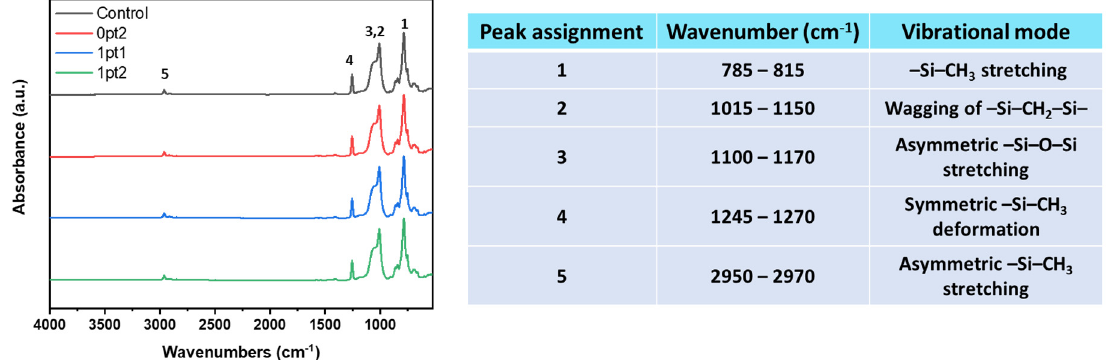
Figure A1. FTIR spectra of formulations along with their peak assignments.